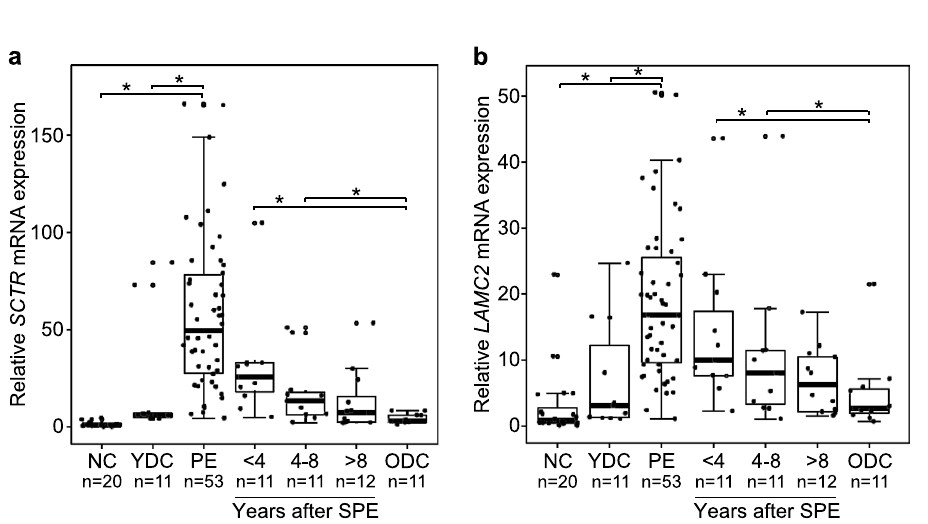
Figure 1. Relative liver mRNA expression of secretin receptor ( SCTR ) and laminin subunit gamma-2 ( LAMC2 ). Box plots (median, interquartile range and 90th percentile with jittered data points) of liver ( a ) SCTR and ( b ) LAMC2 expression in normal controls (NC), young disease controls (YDC), old disease controls (ODC), biliary atresia patients at portoenterostomy (PE) and during follow-up after successful PE (SPE). * P <